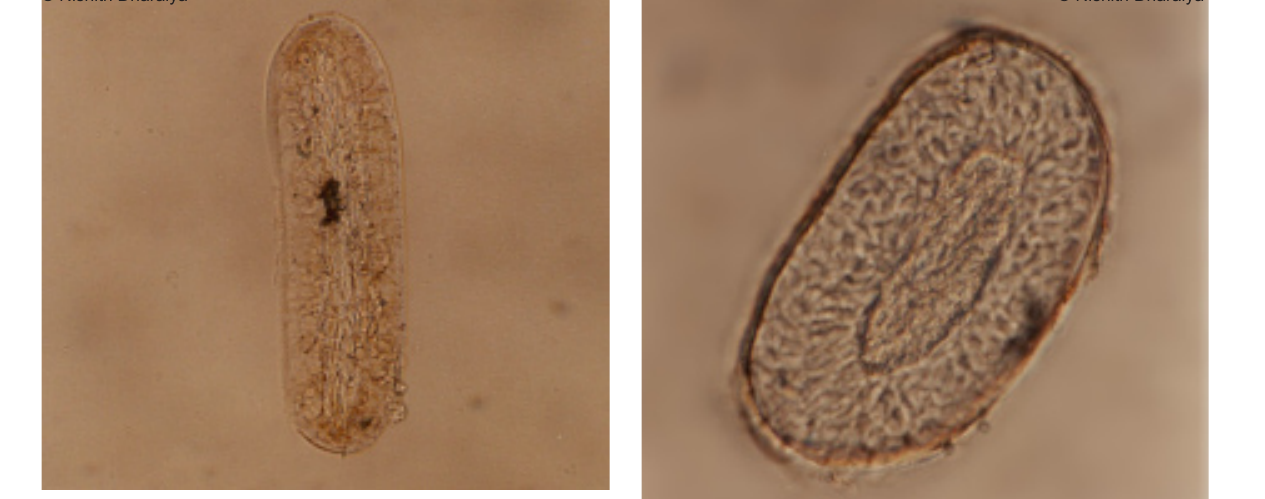
Image 8. Cross section of hair of Chinkara